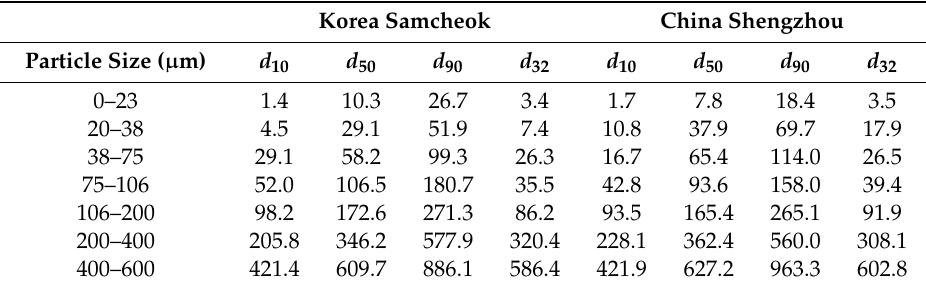
Table 2. The main cut sizes of the seven groups of the two kinds of limestone samples.